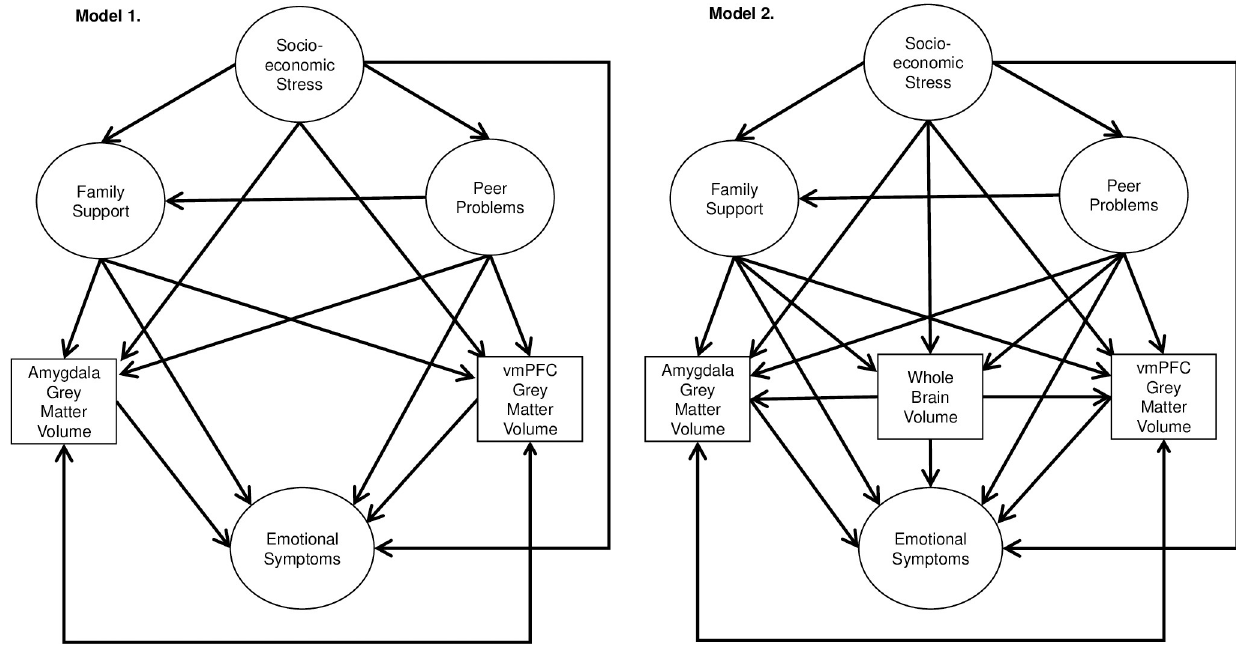
Fig 2. Path diagrams of the structural equation models tested. Note: Single-headed arrows show the hypothesised direction of the relationship. Double- headed arrows show covariance. Latent variables are presented in circles; observed variables are in squares. Separate models were run for males and females. Covariates and indicator variables for the latent variables are not shown for